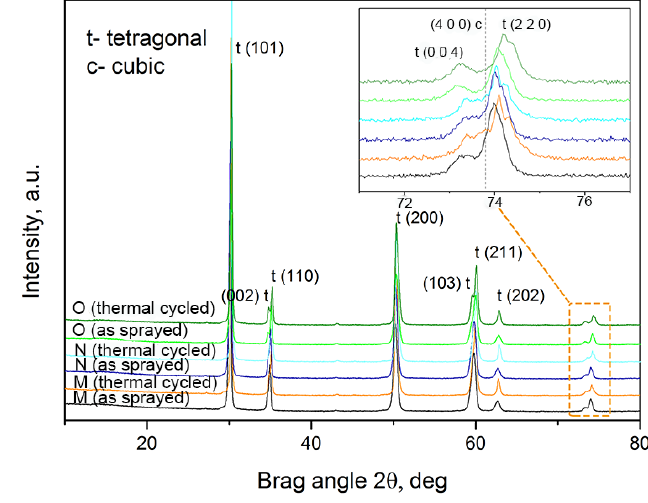
Figure 9. X ‐ ray diffractograms of the as ‐ sprayed and thermally ‐ cycled YSZ samples (M, N, and O).